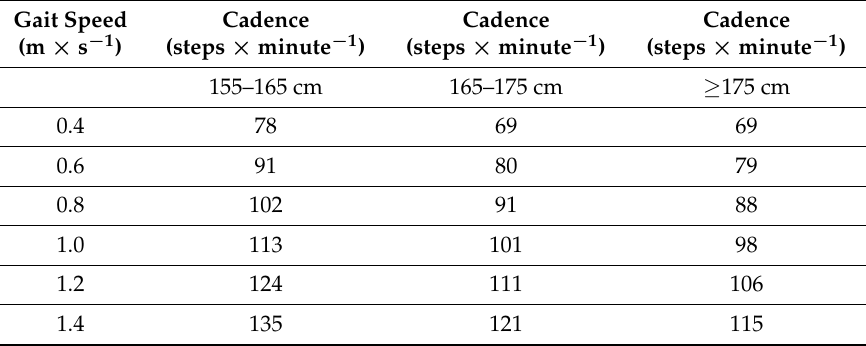
Table 2. Cadences calculated for IMS creation of three different body height ranges and six different gait velocities. Gait Speed Cadence Cadence (m × s − 1 ) (steps × minute − 1 ) (steps × minute − 1